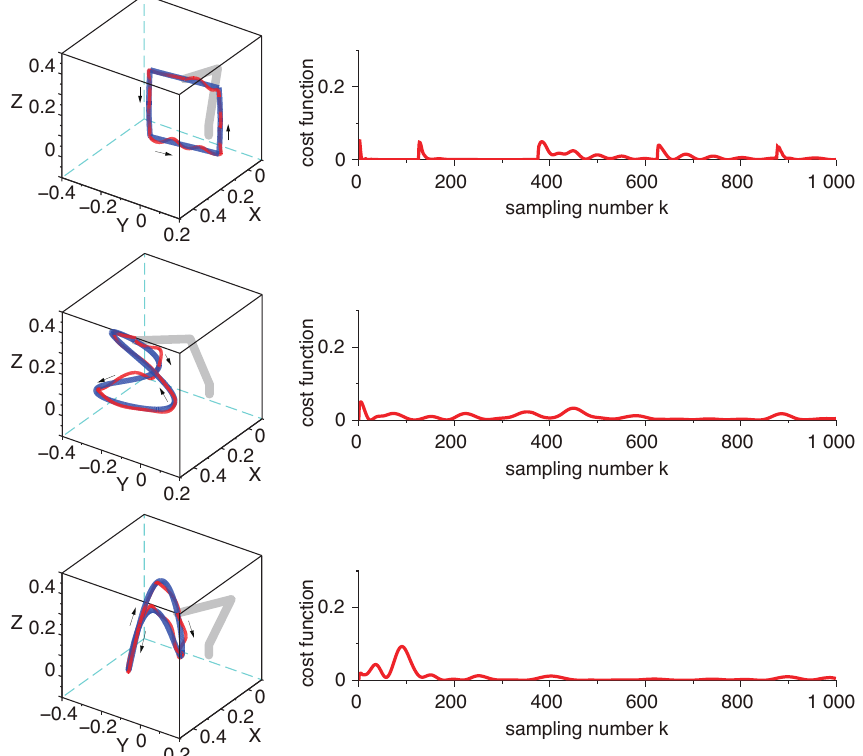
Figure 5. Examples of responses for controlling the robot manipulator using the QNN-based feedforward–feedback controller against untrained conditions, where the desired trajectory and the robot manipulator’s initial condition are as follows: in the top figure, a square and π π π ] T ; in the middle figure, a Lissajous curve and θ ( 0 ) = [ − 3 π ] T ; in θ ( 0 ) = [ 0 − π 2 9 3 12 16 3 π ] T . In each figure, the left figure − π the bottom figure, a Lissajous curve and θ ( 0 ) = [ − 3 π 8 8 4 illustrates the system response in the workspace where the desired trajectory and the response of the end-effector are drawn with thick and medium thick lines, respectively. The arrow indicates the direction of the end-effector’s movement and the stick figure illustrates the initial posture of the robot manipulator, whereas the left figure shows the variation of the cost